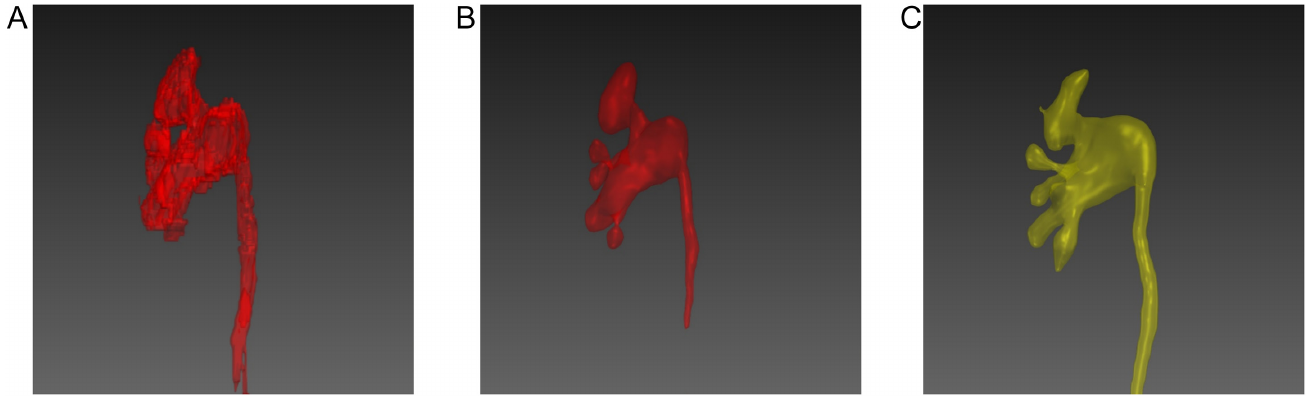
Figure 2. A-C. Anterior view of distended PCS being 3D reconstructed based on excretory and native phases. A, reconstruction of the non-contrast 3D model before smoothing; B, reconstruction of the non-contrast 3D model after smoothing; C, 3D reconstruction based on CT images of excretory phase. PCS, pelvicalyceal system, 3D, 3 dimensional; CT, computed